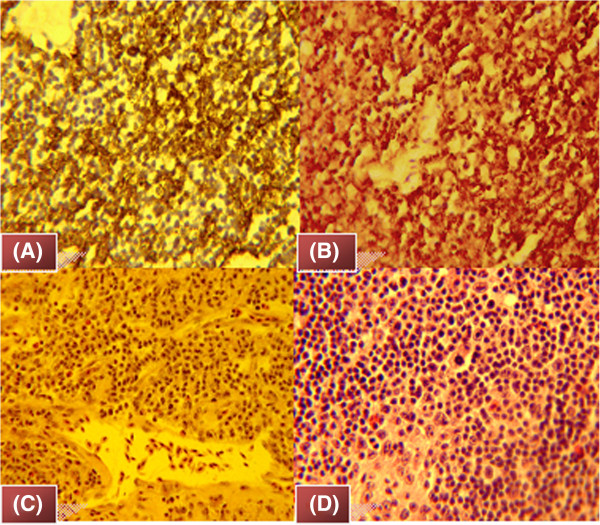
Mix ed thymoma; Immunohistochemical staining mixed thymoma with, CK 14(A) and CK 18 (B) are positive for the round cells of the tumor. Hematoxylin and eosin staining of tissue and cells sections. (C): In vessels, the tumoral cells were seen. Numerous eosinophils in vessels indicated eosinophilia (H&E;20 μ×200). (D): The histiocytes with light nuclei and pink cytoplasms among tumoral lymphoid cells were observe. (H&E;25 μm×400).